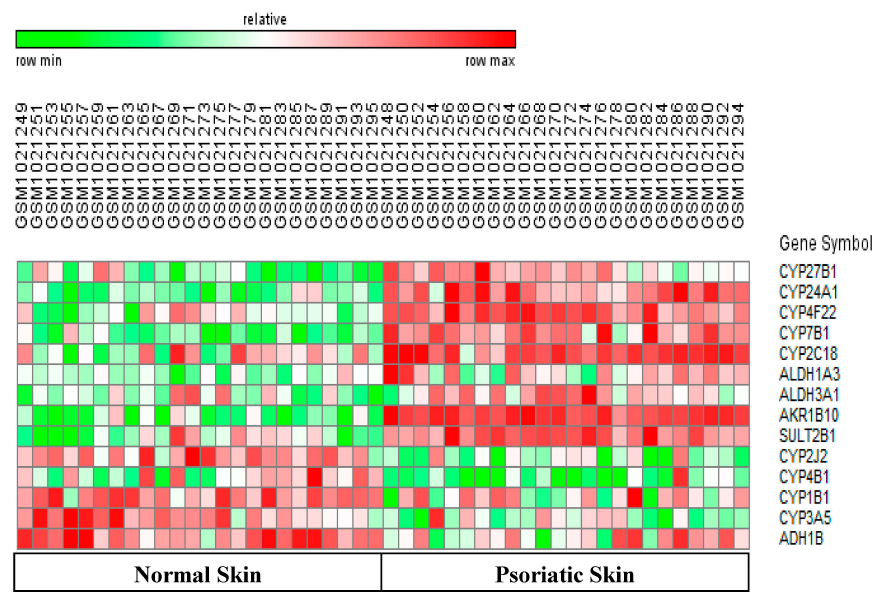
Figure 1. Heatmap of DEGs from GSE 41662.Psoriatic skin showed upregulation of genes controlling metabolism of vitamin D (CYP27B1, CYP24A1), vitamin A (ALDH1A3, AKR1B10), barrier formation (CYP4F22, SULT2B1), antioxidant defense (ALDH3A1, ADH1B), cholesterol catabolism (CYP7B1), and drug metabolism (CYP2C18). Genes metabolizing arachidonic acid (CYP2J2, CYP4B1) and drugs (CYP4B1, CYP1B1, CYP3A5) were down-regulated in psoriasis. Genes with high and low expression are rendered in red and green, respectively. Pharmaceutics 2016 , 8 , x